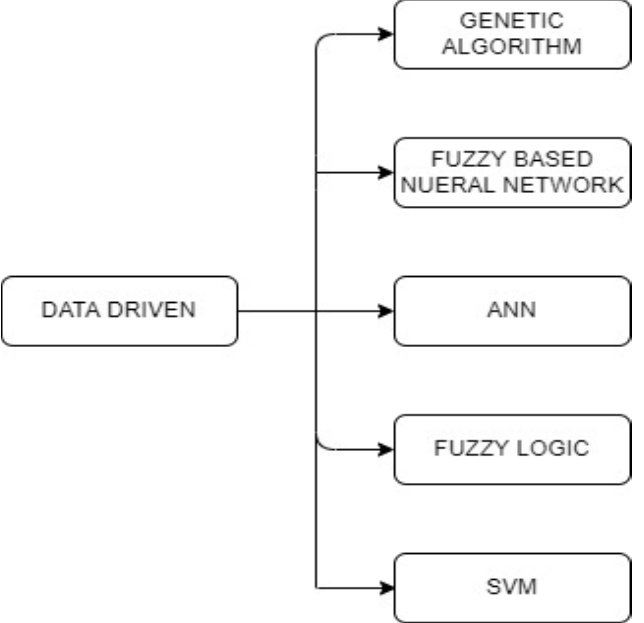
Figure 17. Parameter Estimation Methods.